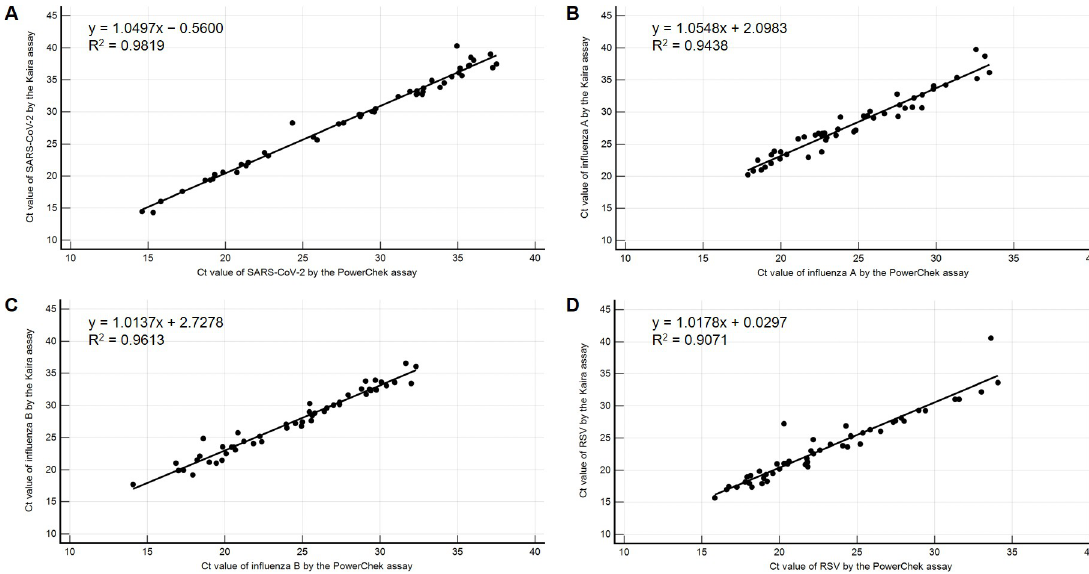
Fig 2. Correlation between Ct values of clinical specimens tested positive by both the Kaira and PowerChek assays. (A) E and ORF1ab Ct values of the PowerChek assay were averaged and plotted against the ORF1ab Ct values of the Kaira assay. (B) Influenza A Ct values of the PowerChek assay were plotted against the influenza A Ct values of the Kaira assay. (C) Influenza B Ct values of the PowerChek assay were plotted against the influenza B Ct values of the Kaira assay. (D) RSV Ct values of the PowerChek assay were plotted against the RSV Ct values of the Kaira